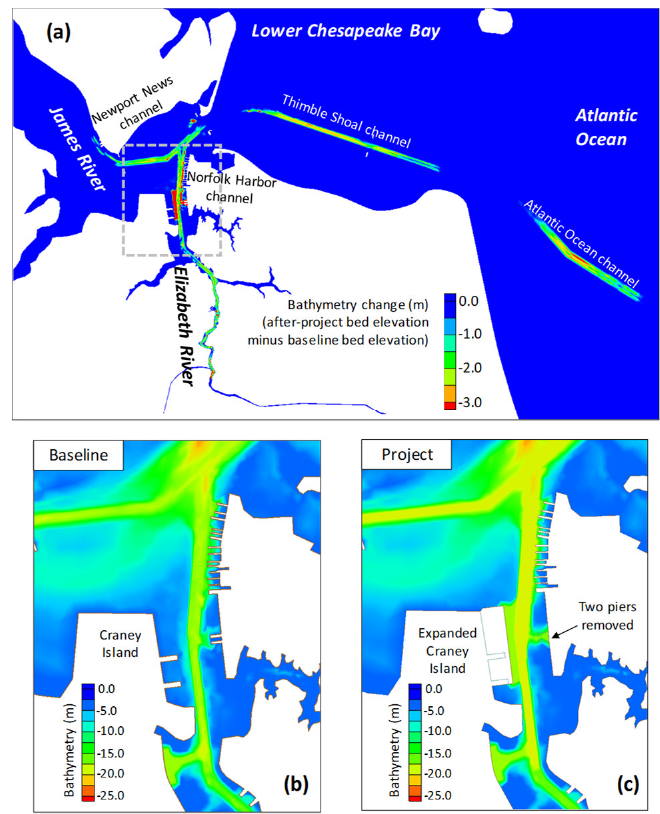
Figure 3. Project description: ( a ) the bathymetry difference due to channel dredging; ( b , c ) localized changes in the channel shape and bathymetry near the Craney Island. The spatial extent of ( b , c ) is highlighted in ( a ) by a dash-line box. The faint boundary lines near the Craney Island in ( c ) only serve as a reference to the baseline condition but not physically present in the project